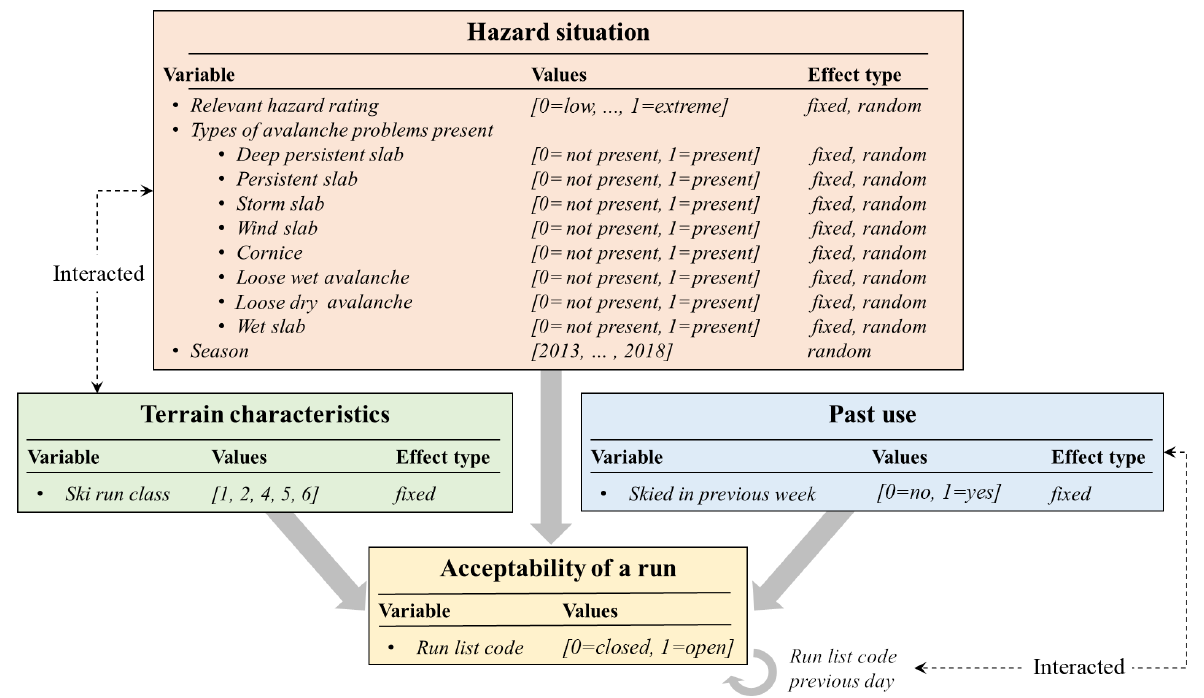
Figure 4. Illustration of the model. Our model included variables describing the hazard situation, the terrain characteristics of a ski run, and its past use to examine their relationships with the acceptability of a run (e.g., it being coded “open”). To account for the iterative character of the terrain assessment process, the model also included the run list code from the previous day. In addition to the fixed effects, we included by-run and by-season random effects. Table 2. Main effects. Diagnostics and posterior summary statistics of the estimated parameters from the mixed-effect logistic regression model. ESS is the effective sample size for each parameter. Significant parameter estimates are indicated in bold. Non-significant (ns) ORs are omitted. Value ESS Mean